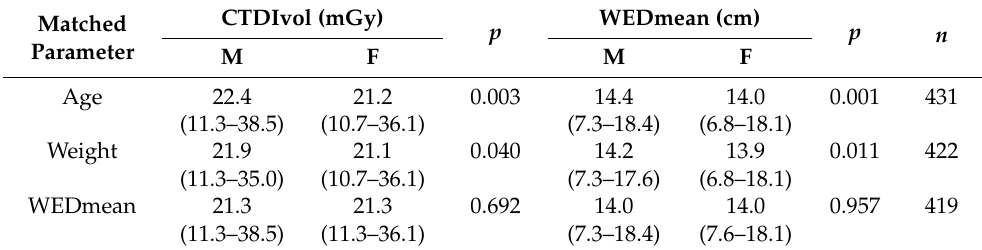
Table 2. Sex-dependent differences in CTDIvol and